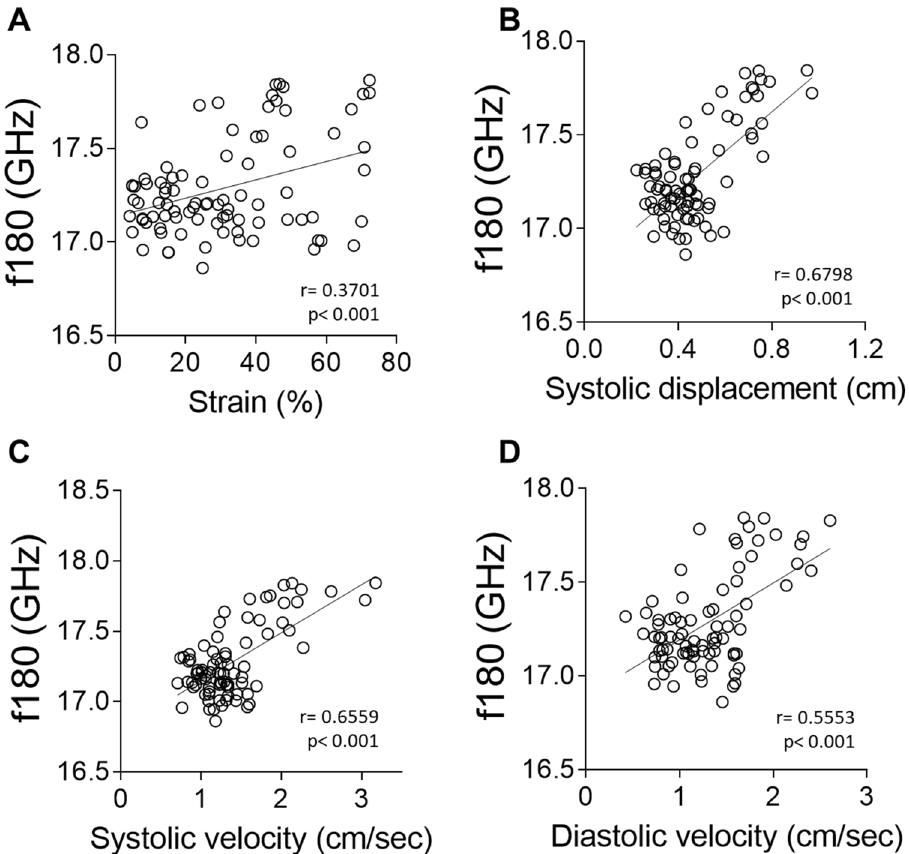
Figure 4. Brillouin frequency shifts correlate with radial wall deformation and motion indexes measured by echocardiography. ( A – D ) Correlation between mBS frequency shift and radial strain ( A ), radial systolic displacement ( B ), radial systolic velocity ( C ), and radial diastolic velocity ( D ) measured by 2D speckle tracking with echocardiography. Statistical analysis was performed using Pearson correlation coefficient